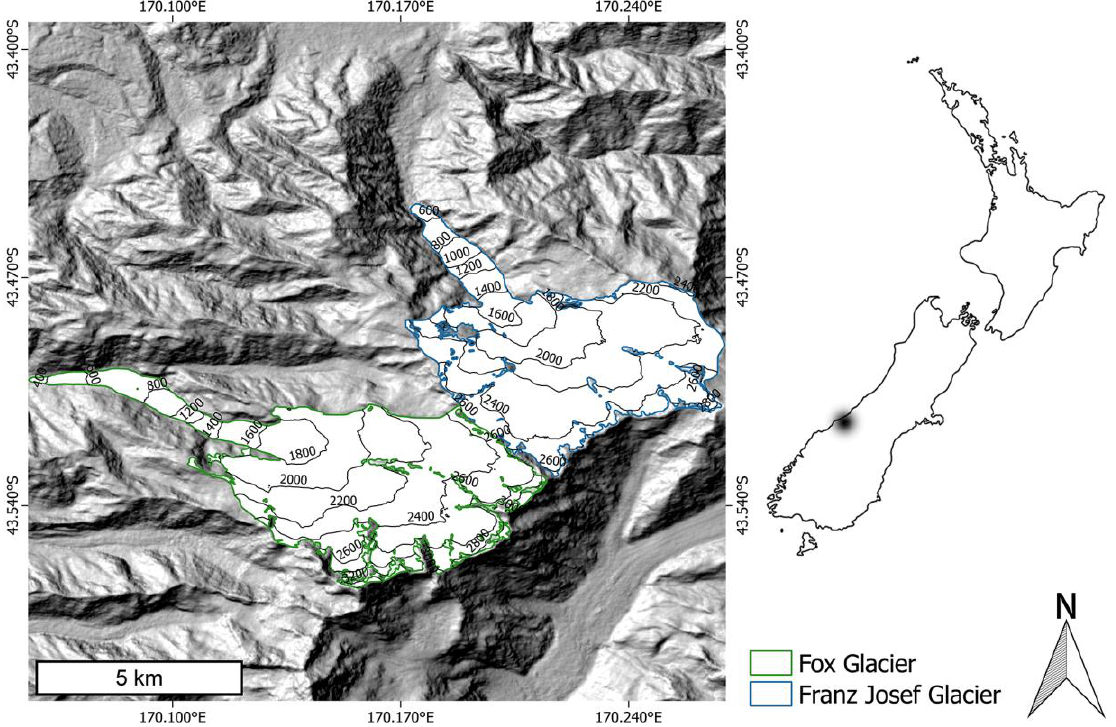
Figure 1. Study area. Shaded relief showing Fox Glacier and Franz Josef Glacier located in the Southern Alps, New Zealand. Glacier extents are from the Randolph Glacier Inventory